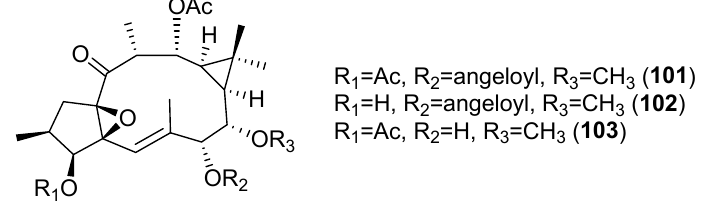
Figure 16. Ingol-type diterpenes ( 101 – 103 ) with cytotoxic activity. Mode of Action